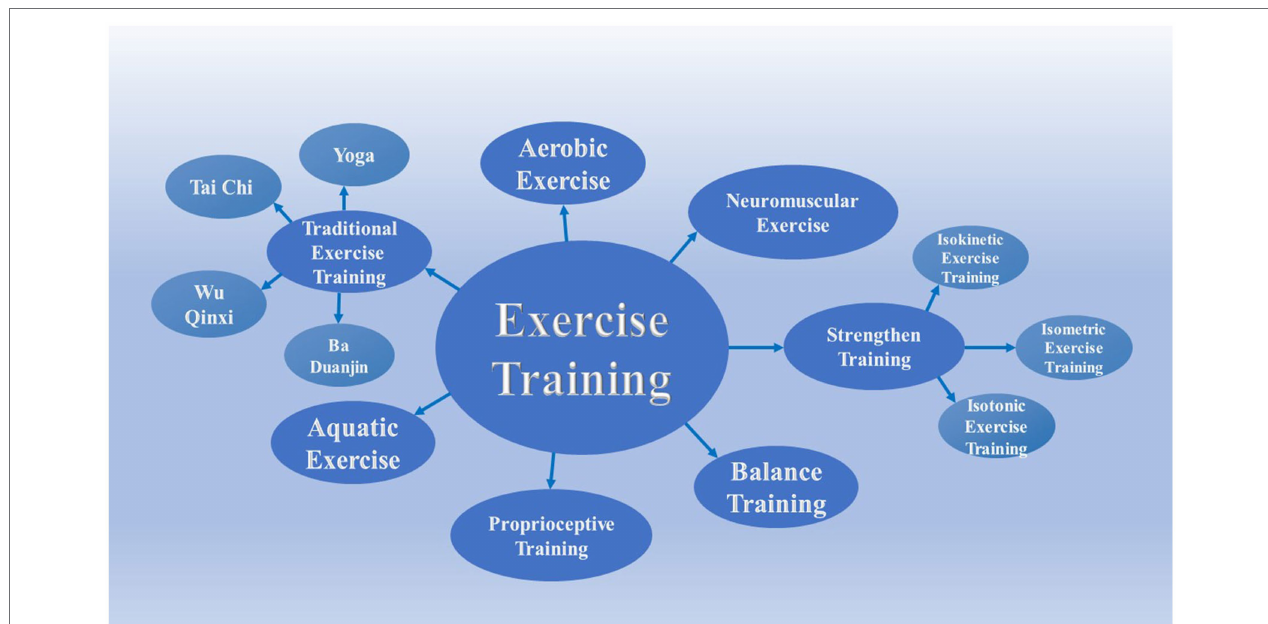
FIGURE 4 | Different exercise training types of KOA. There are several exercise trainings options for treating KOA in the clinic, including aerobic exercise, strength training, neuromuscular exercise, balance training, proprioception training, aquatic exercise, and traditional exercise. Strength training includes isokinetic exercise, isometric exercise, and isotonic exercise. Traditional exercise includes Ba Duanjin, Tai Chi, Wuqinxi, and